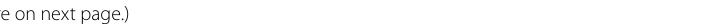
(See figure on next Fig. 8 Imatinib has no effect on pericytes covering microvessels but reduces inflammation and microvessel leakage after SCI. a Representative immunofluorescence images of CD31 (red), PDGFRβ (green), and DAPI (blue) in mice treated with intrathecal injection of imatinib or PBS (control) at 14 days post‑injury (dpi). Enlarged images of the dotted line in the left panel are shown in the right panel. b Representative immunofluorescence images of CD31 (red) and fibrinogen (green) in mice treated as above. The lower panel shows high magnification image in the dotted box in the upper panel. c Representative immunofluorescence images of GFAP (green) and CD68 (red) in mice treated as described above at 14 dpi (upper panel) and 28 dpi (lower panel). Scale bars: 100 μm ( a , upper panel in b and c ) and 20 μm (lower panel in b ). All images are from sagittal sections. d – f Quantification of the percentage of microvessel covered by PDGFRβ + cells ( d ), fibrinogen leakage ( e ), and the CD68 + inflammatory area ( f ) in a – c . Data are expressed as mean s.e.m. n 4–6 per group. NS, no significance; *** p < 0.001 versus control by unpaired two‑tailed Student’s t test ± = in d , e , and f